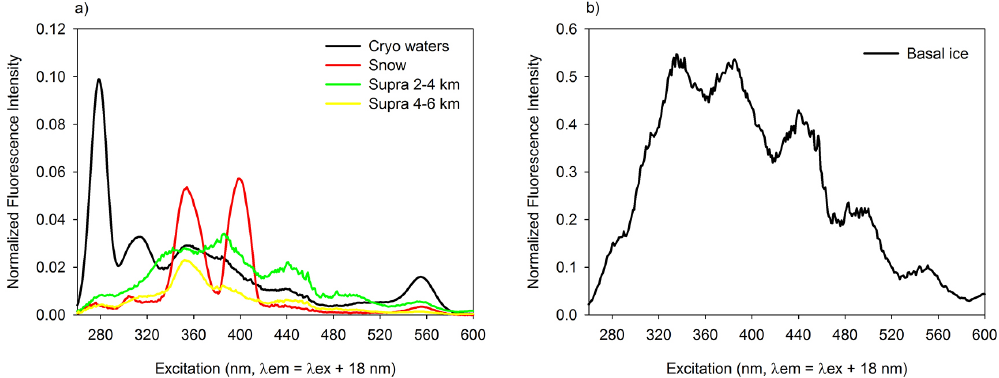
Figure 7. Synchronous fluorescence spectra for averaged (a) supraglacial water samples ( n = 7, 7, 3 and 10 for the supra 2–4km, supra 7–50km, snow and cryoconite waters (2011 samples only), respectively) and (b) basal ice ( n = 7). λ em = λ ex + 18nm. All spectra have been normalised to the highest fluorescence peak spectral maximum in the entire data set. Note the difference in scale on the y